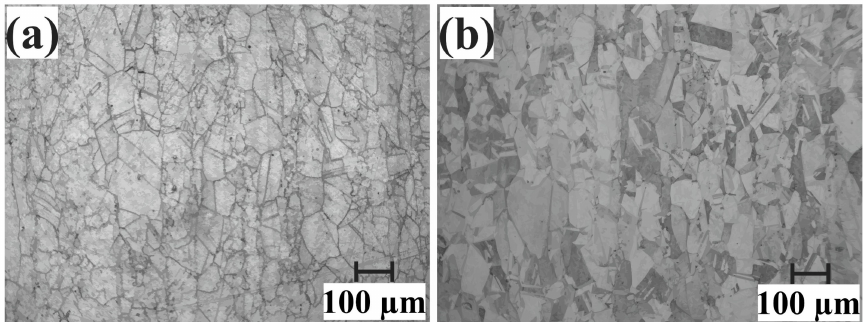
Figure 2. Micrographs of the etched microstructure of the Sol-Wasp alloy ( a ) and the Age-Wasp alloy ( b ). Etchant: 10 g CuCl, 40 mL HCl, 60 mL